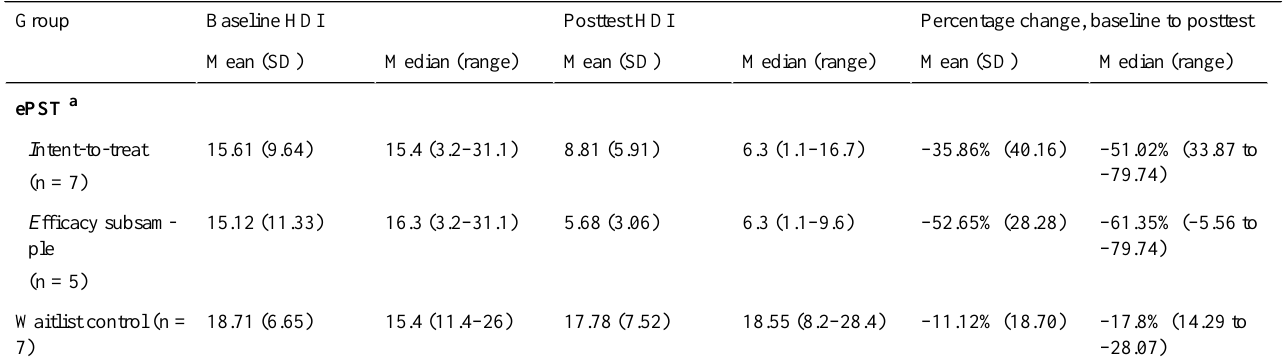
Table 4. Percentage change in depression as measured by the Hamilton Depression Inventory (HDI).